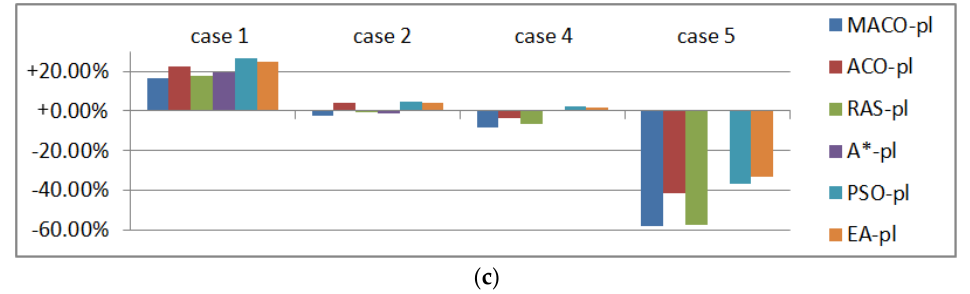
Figure 24. Planning results under threat environments. ( a ) Processing time (s); ( b ) Comparison with L min ; ( c ) Comparison with H avT .